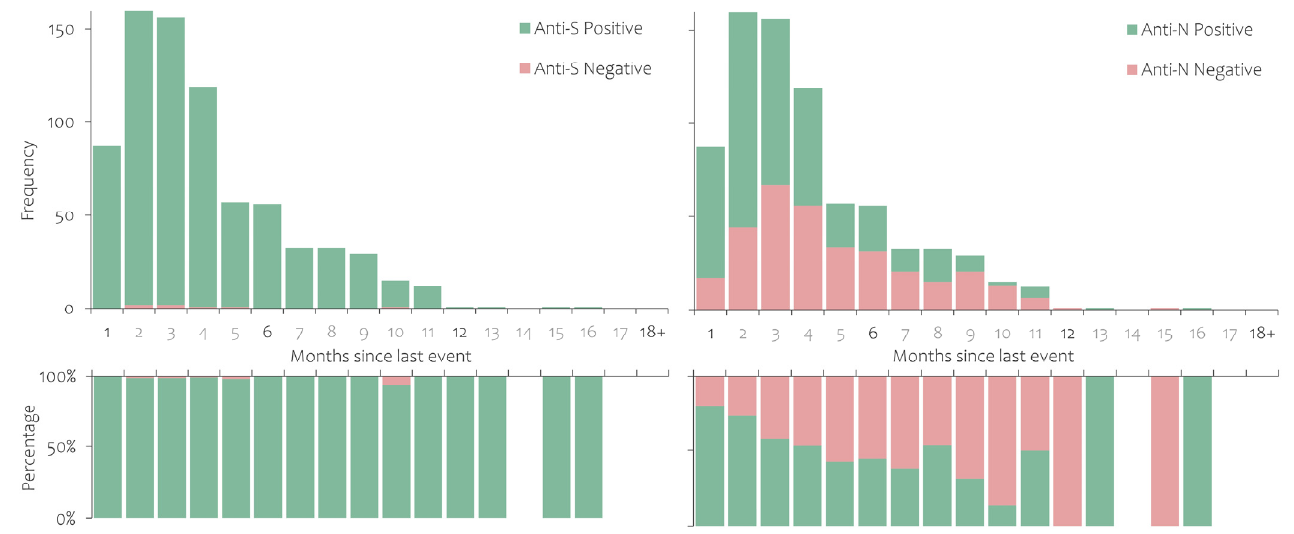
Figure 4. Anti-S and anti-N antibody persistence in study participants who were notified as infected with SARS-CoV-2 and had received at least one dose of a COVID-19 vaccine. From the time of serum collection to 14 November 2022, a total of 445 participants (15.3%) tested positive for SARS-CoV-2 (Table 4). Those who tested negative for anti-N and anti-S antibodies were between 40 and 59 years old, and those who did not have a notified previous infection had higher odds of infection. Vaccination status and gender had no significant effects on the risk of infection. When controlling for other variables, middle-aged participants had the highest odds for infection after serum sampling, fol- lowed by participants with no anti-S and anti-N antibodies. Table 4. Anti-S and anti-N seroprevalence, gender, age groups, registered SARS-CoV-2 infection before sampling, and COVID-19 vaccination status in participants who tested positive for SARS- CoV-2 after sampling.